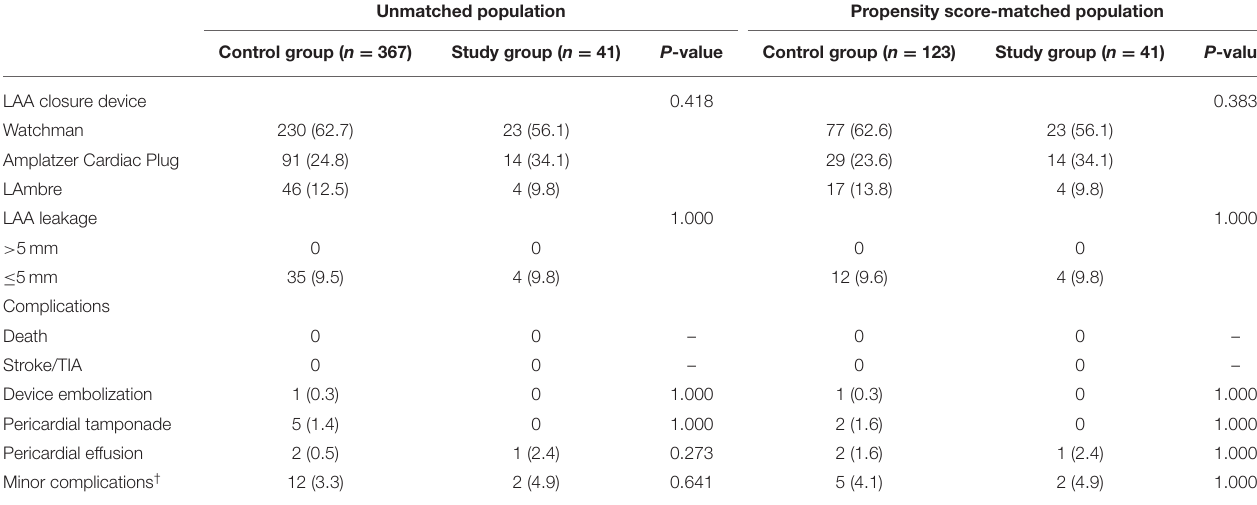
TABLE 2 | Peri-procedural data.